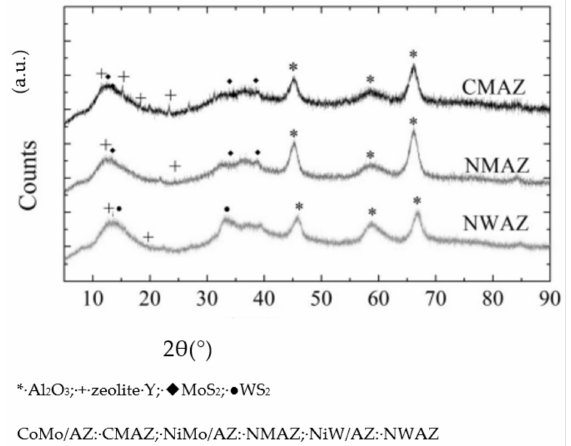
Figure 2. XRD profiles of the sulfided